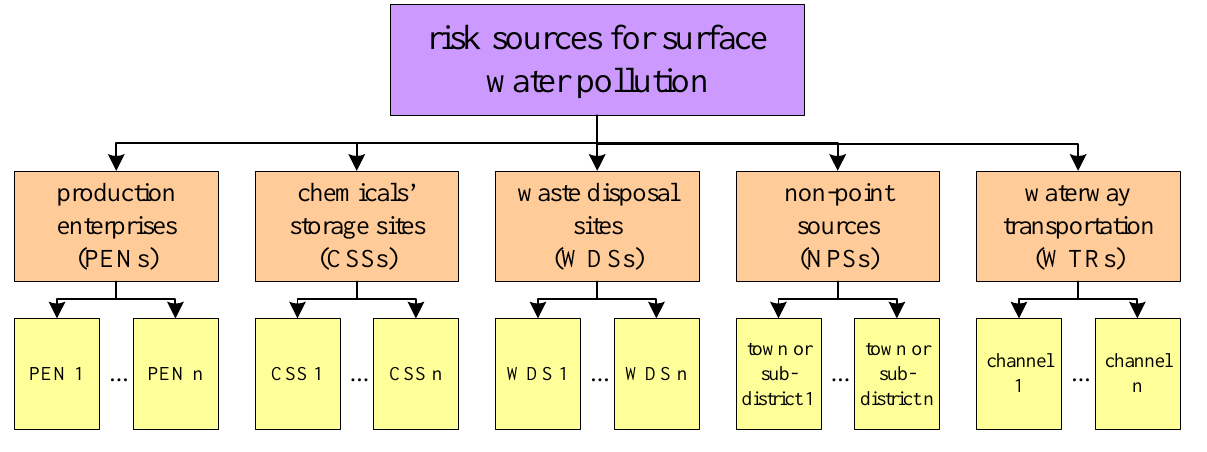
Figure 2. Types of risk sources and units of risk